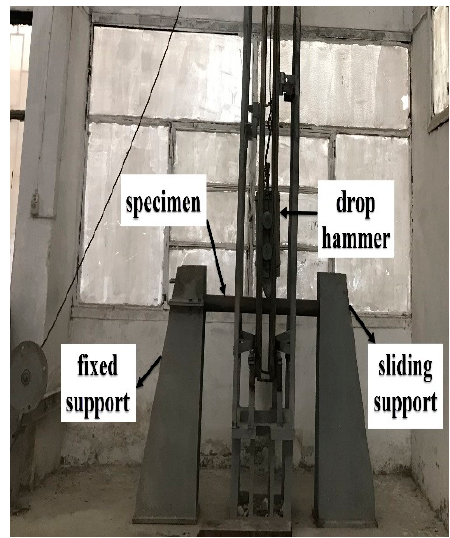
Figure 2. Drop weight impact machine.